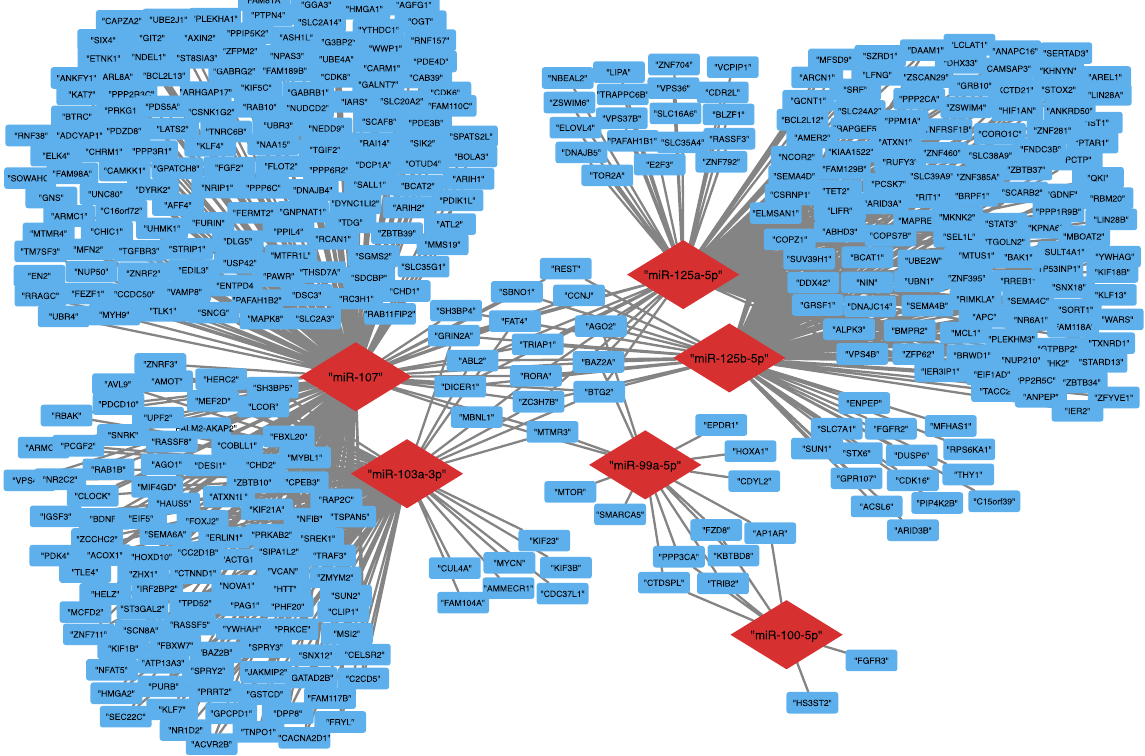
Figure 7. Interaction network of 6 altered serum miRNA in prion-infected elk and hamster with target genes. The conserved 6-miRNA signature targeted a total of 422 target mRNA molecules. Red diamonds indicate miRNAs and blue rectangles indicate target genes.